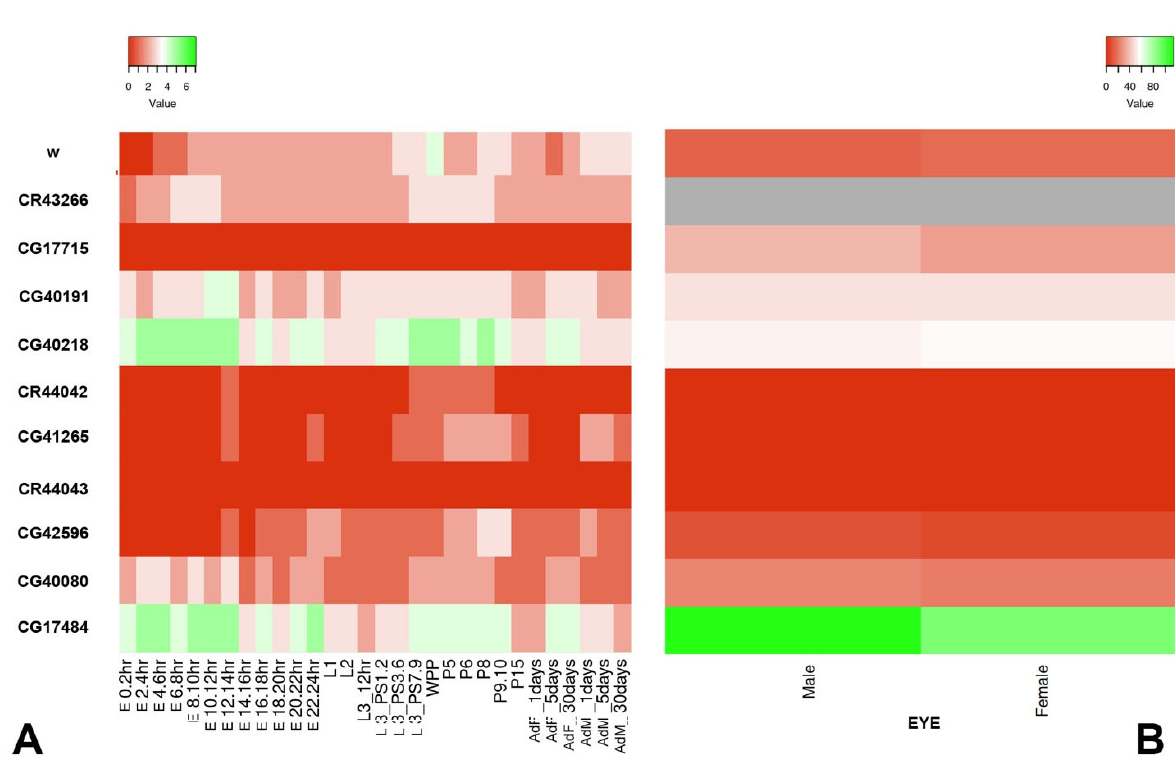
Figure 3. Heatmaps showing expression profile of the heterochromatic genes linked to the examined Pw + reporters compared to that of white gene. Expression across developmental stages ( A ) and in the eyes of males and females ( B ). Shades of color from red to green indicate the expression bin classification from 1 (no/extremely low expression) to 7 (very high expression). The gray color means that no data about CR43266 expression are available. Developmental stage and eye expression data were obtained from FlyBase and FlyAtlas, respectively.